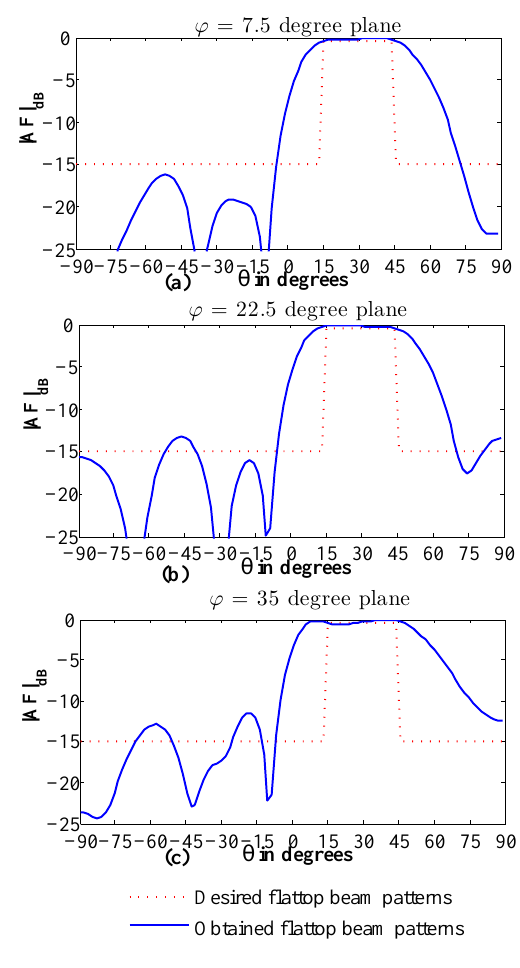
Figure 6: Scanned Flat-top patterns in arbitrary planes (a)